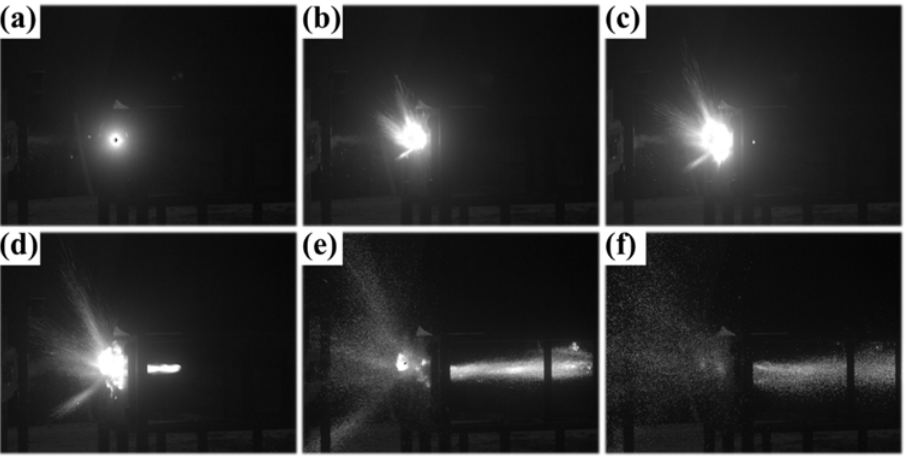
Figure 8. Ce5 fragment penetrating a 6 ‐ millimeter A 3 plate: ( a ) 0.1 ms, ( b ) 0.4 ms, ( c ) 0.7 ms, ( d ) 1.3 ms, ( e ) 4.1 ms and ( f ) 9.8 ms.